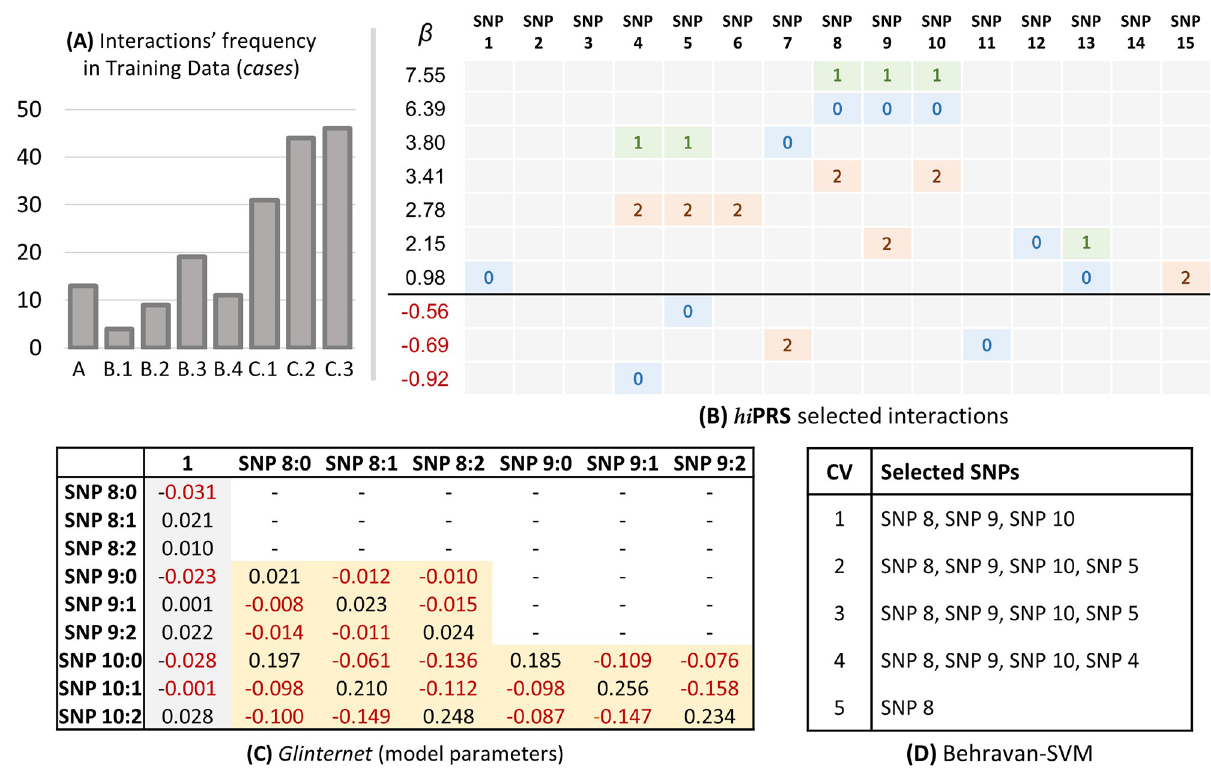
Fig 5. Interpretability analysis. (A) Absolute frequency of the generative rules in the training data, limited to the positive class. (B) Interactions selected by hi PRS with K = 10 and corresponding β coefficients. (C) Coefficients of the glinternet model with 3 interaction terms: main effects are in gray, interactions in yellow. (D) Lists of SNPs selected by SVM-Behravan during its five internal cross validations, cf. Benchmark Algorithms in the Materials and Methods Section. Note: reported results are limited to one simulation among the 30 randomly generated datasets.